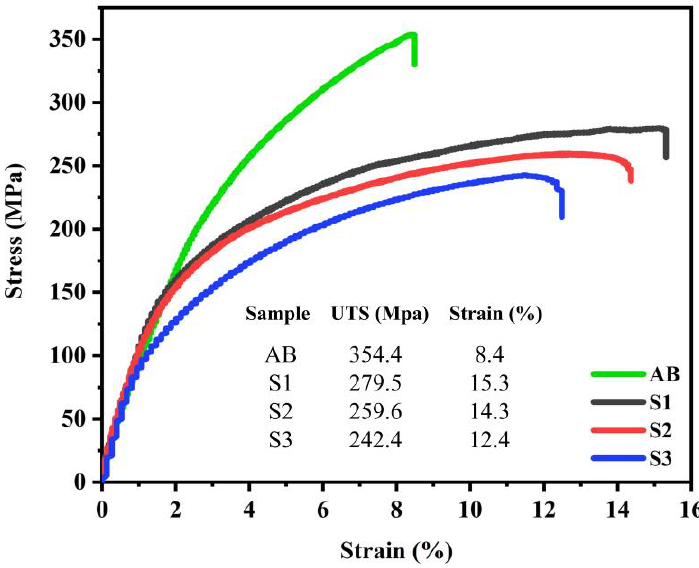
Figure 11. Engineering stress – strain plots of BM and different FSPed samples.